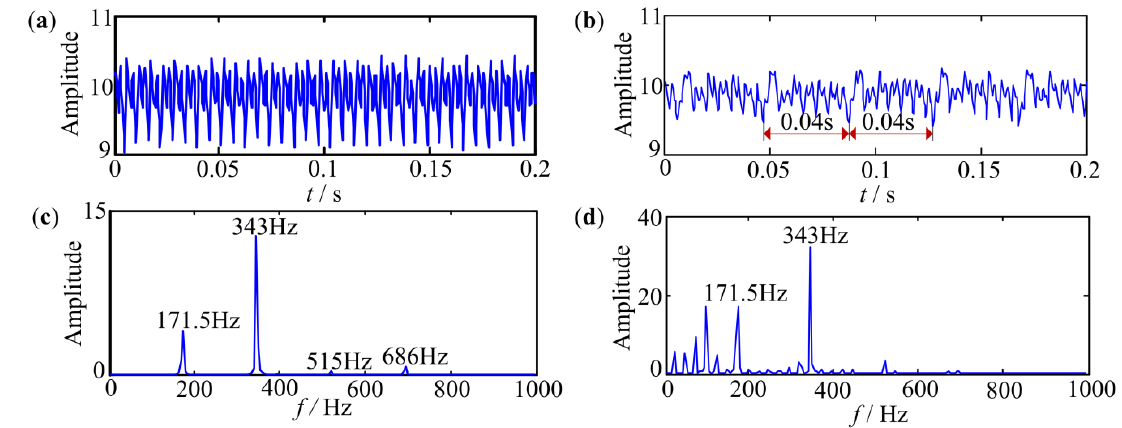
Figure 6. The original signals from ( a ) a normal pump and ( b ) a pump with slight degradation, and the power spectra of the signals from ( c ) a normal pump and ( d ) a pump with slight degradation.